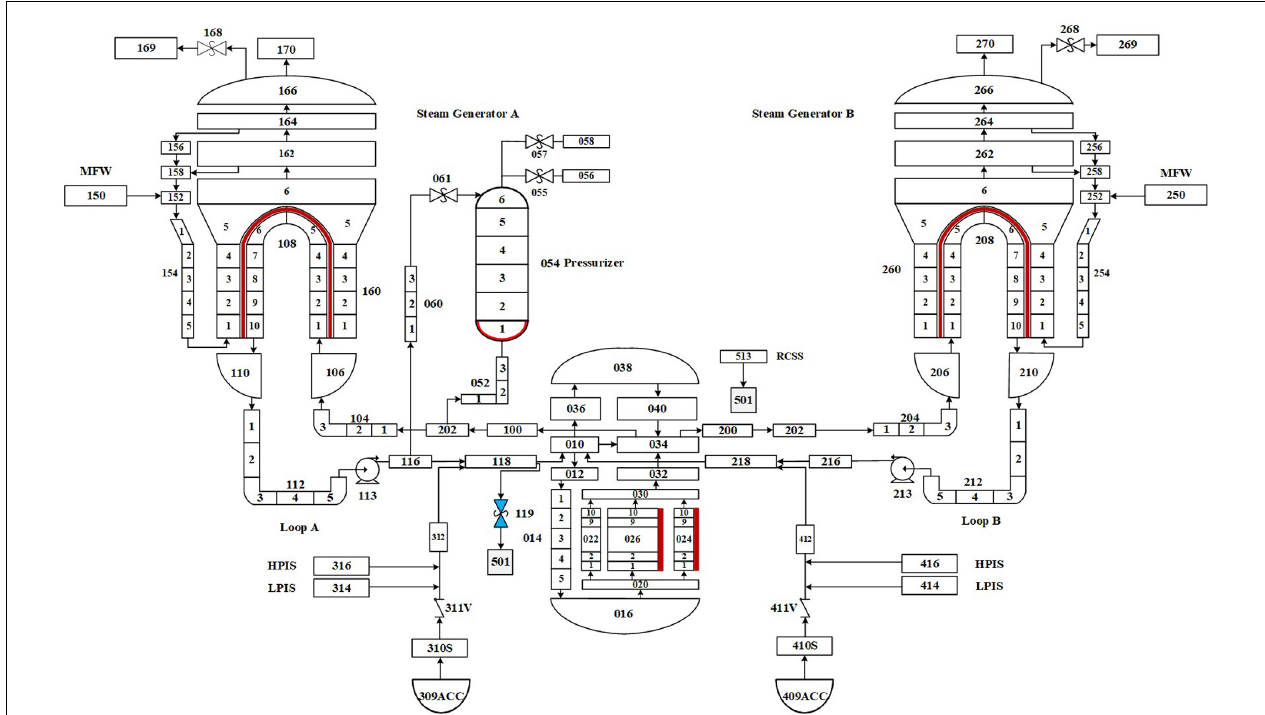
FIGURE 3 | The RELAP5 model